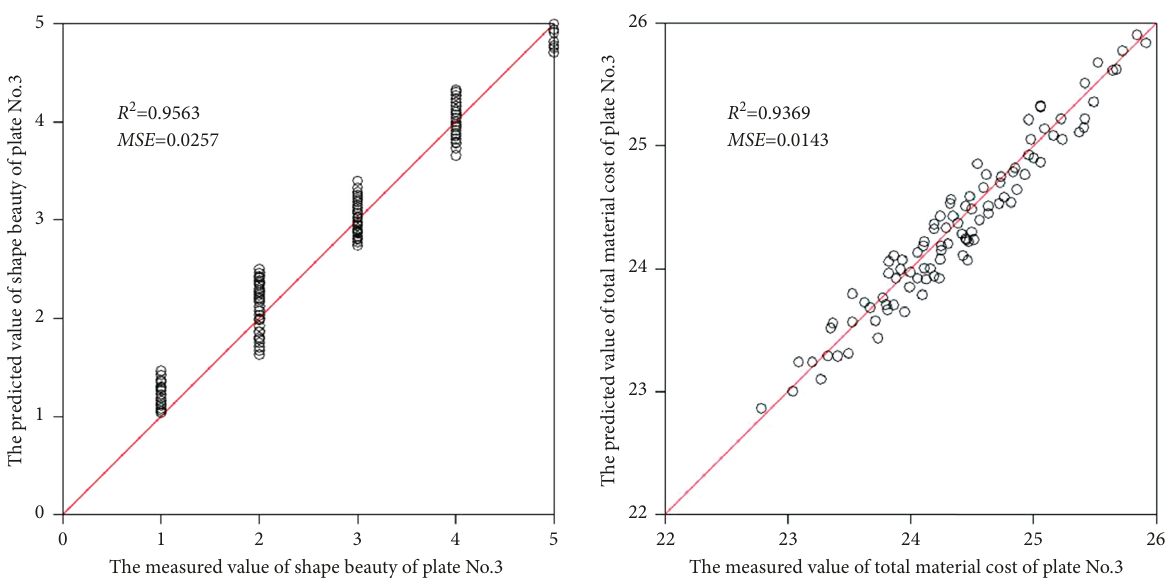
Figure 16: Fitting situation of the training samples in plate no. 3.